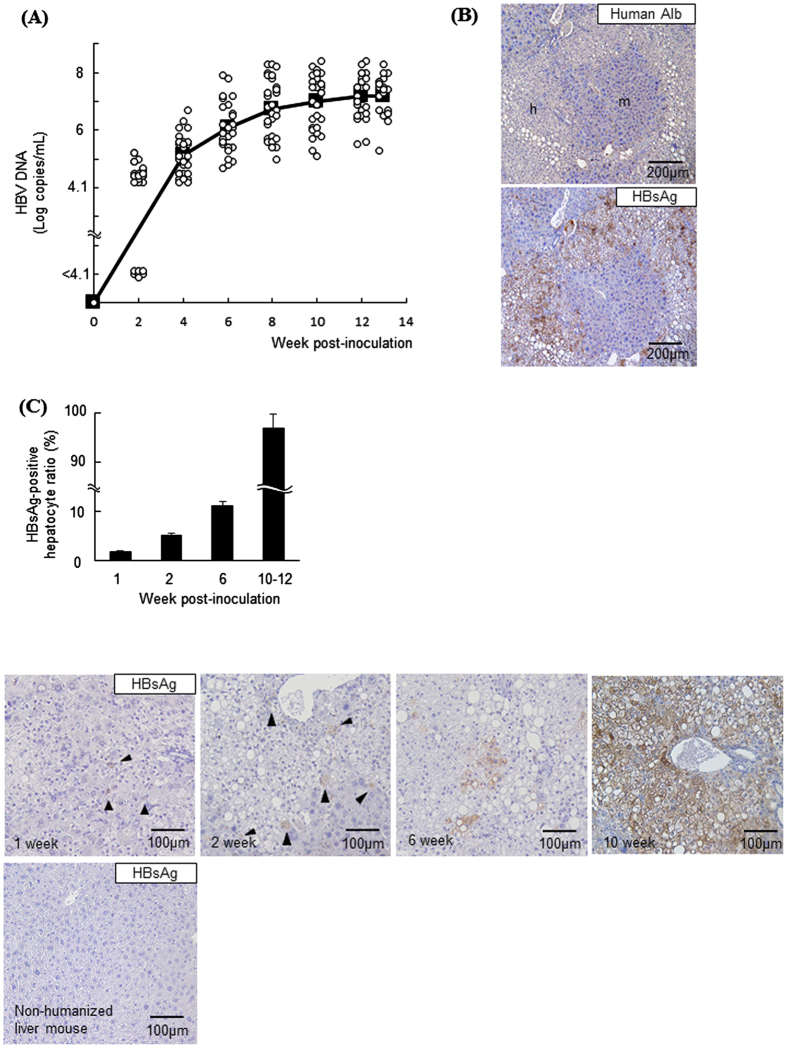
HBV-infected hepatocytes disseminated in chimeric mouse livers.Humanized liver chimeric mice were inoculated with HBV (1.0 × 106.1 copies). (A) Serum HBV DNA levels were measured after inoculation (n = 29). Open circles represent individual HBV DNA levels at the indicated point, closed squares represent the average HBV DNA level at the indicated point. (B) Representative images of human albumin and HBsAg immunohistochemical analysis of serial liver sections at 10 weeks post-inoculation. ‘m’ = mouse; ‘h’ = human. (C) Representative images of HBsAg immunohistochemical analysis and the ratio of HBsAg-positive cells in the livers at the indicated week post-inoculation (n = 3). Arrowheads indicate HBsAg-positive hepatocytes.